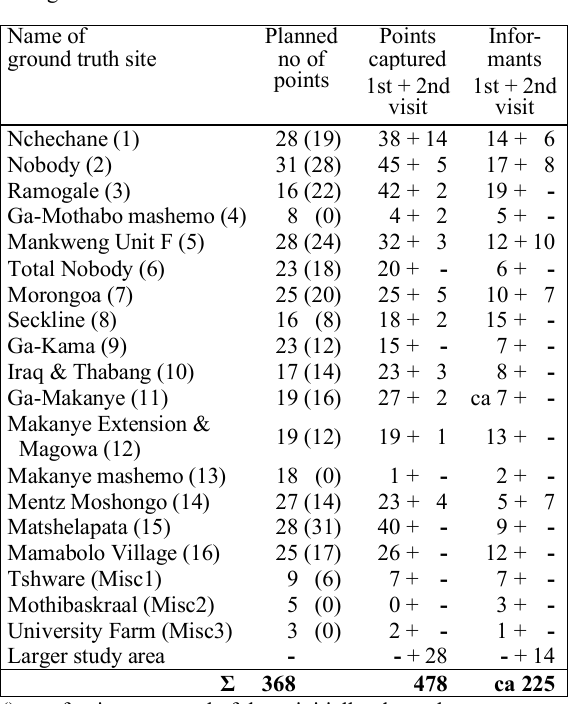
Table 1: Ground truth efforts: number of points captured and number of informants spoken to per site. For location of sites see Figure